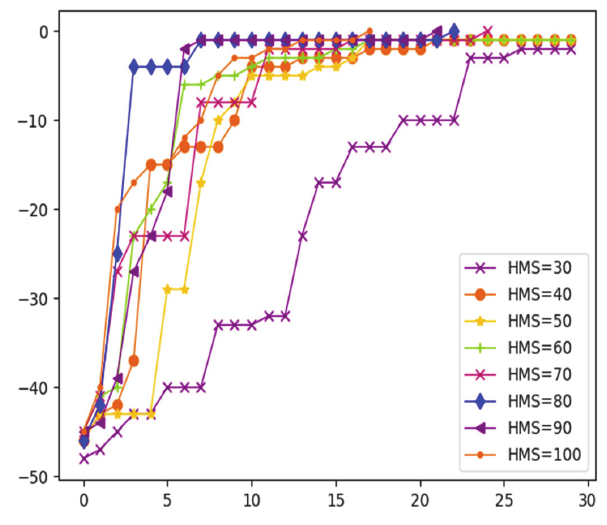
Fig. 19. Effect of HMS on performance of